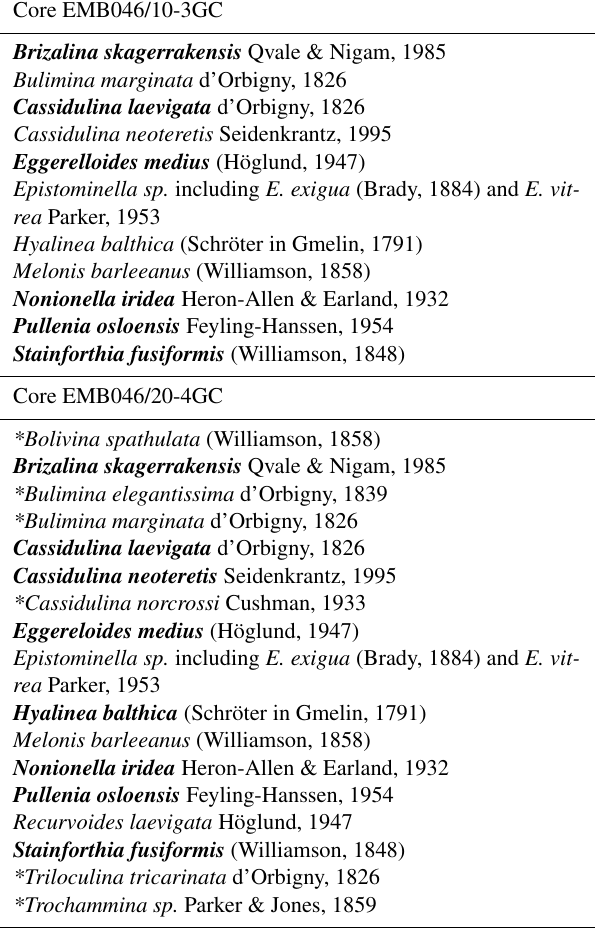
Table 2. List of dominant (bold) and accessory benthic foraminiferal species. The species names marked by “*” represent foraminiferal species with relative abundance >5% in only one sample and thus were excluded from statistic